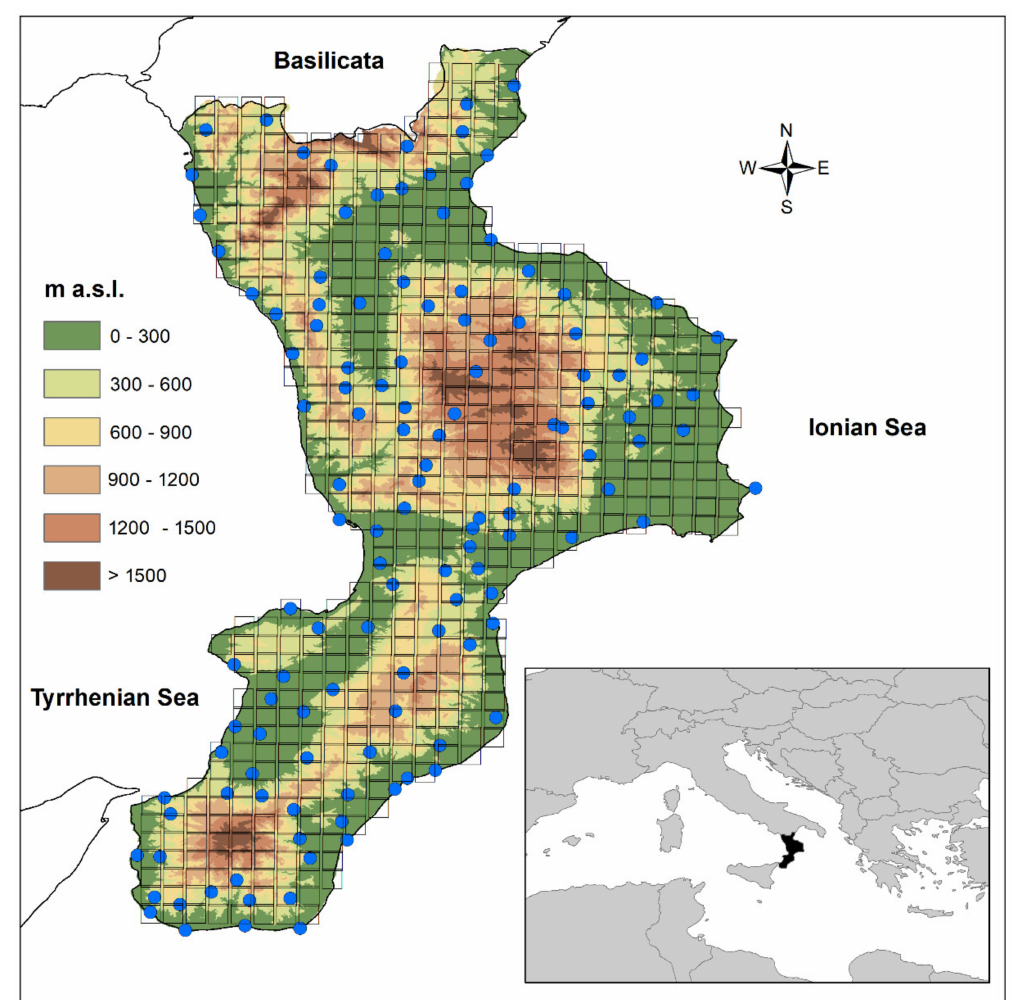
Figure 1. Localization of the rain gauges on a Digital Elevation Model of the Calabria region and visualization of the grid with a spatial resolution of 5 km × 5